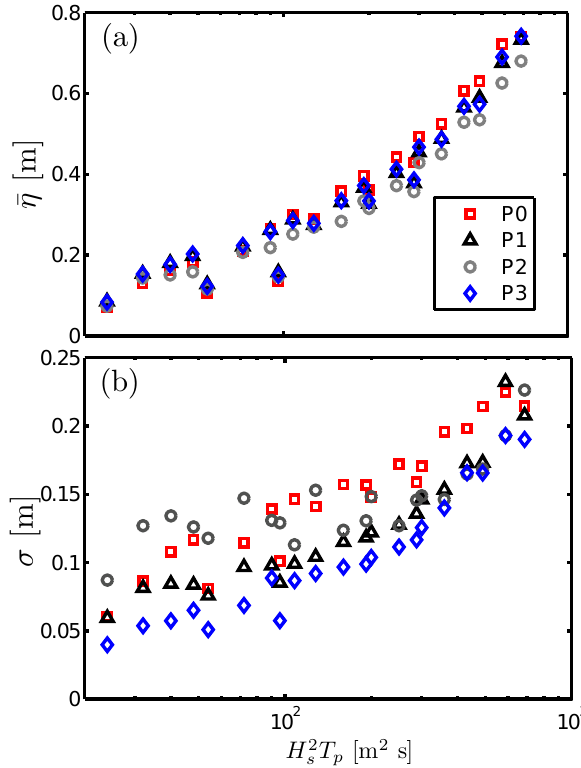
Fig. 8. (a) Wave setup and (b) infragravity-wave energy as a func- tion of wave conditions for all simulated cases at the intersection between the still water level and the cross-reef profile for the loca- tions shown in Fig. 1.